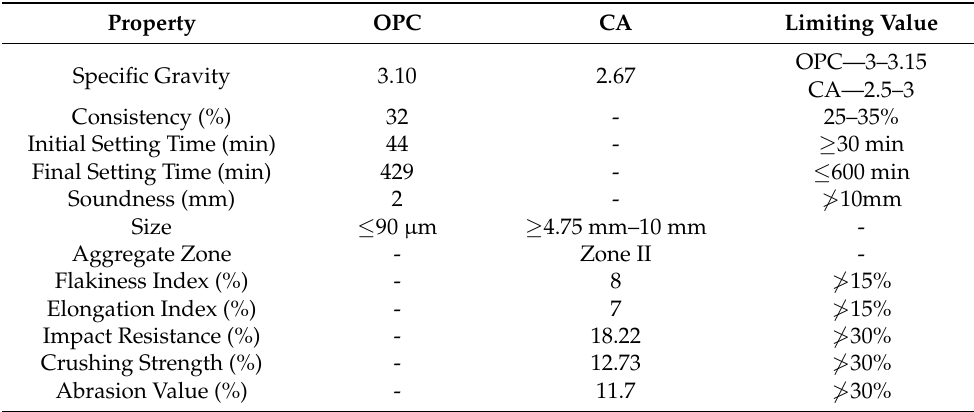
Table 1. Physical Properties of OPC and Crushed Stone